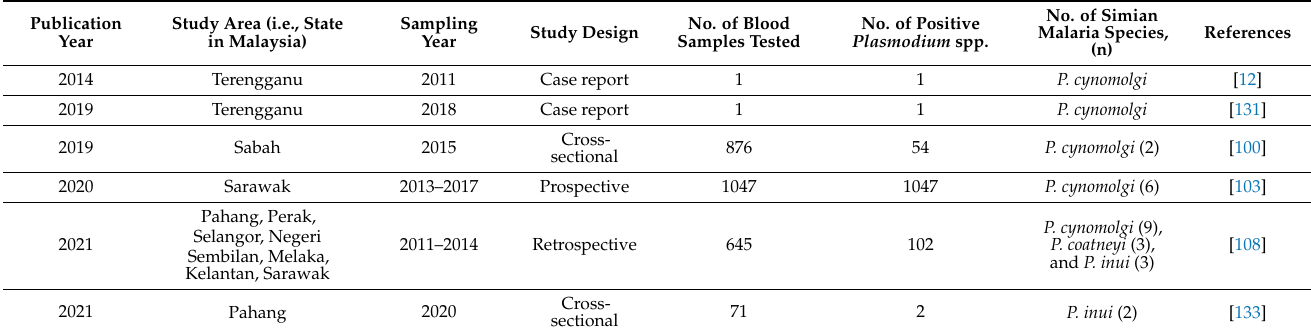
Table 2. Published studies of P. cynomolgi , P. inui , and P. coatneyi in